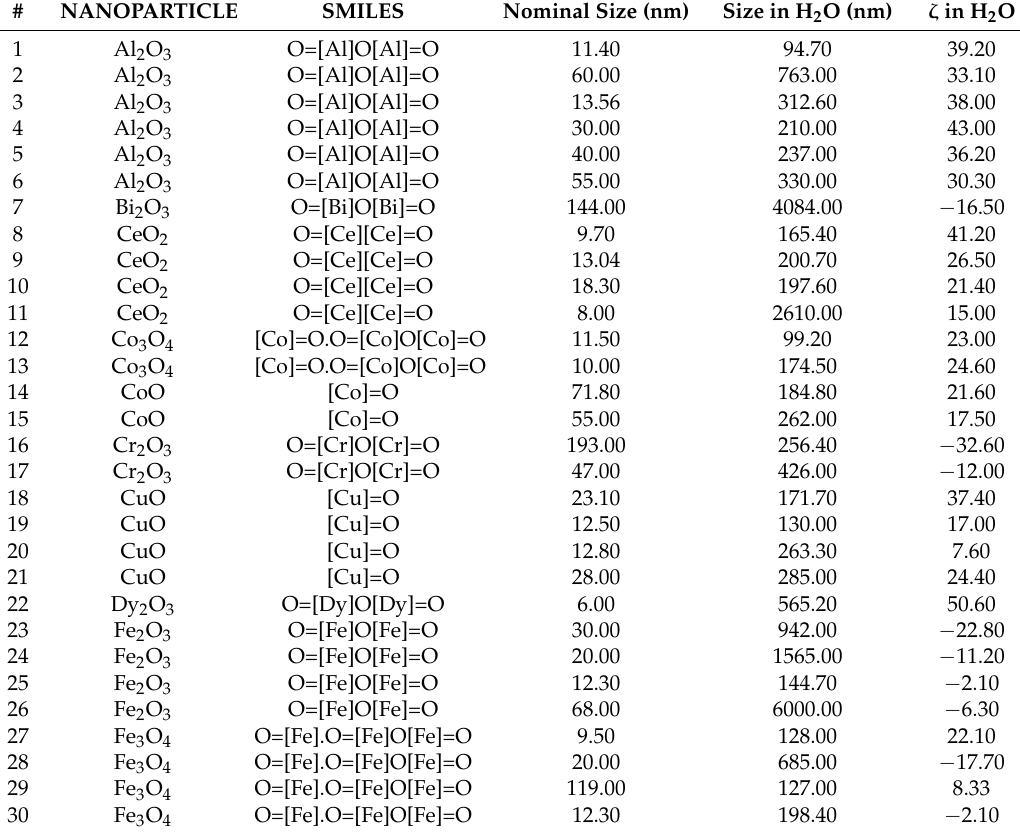
Table 1. Experimental data on zeta potentials and ordinary SMILES